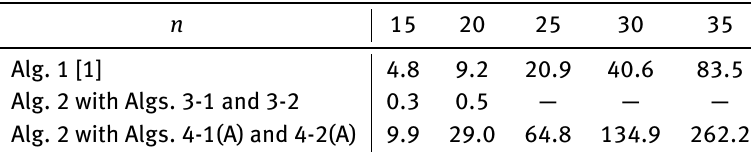
Table 5: Required times (sec) of Algorithms 1 and 2 for T with low symmetry. T were generated from a = (1, 1, 1) , b = (100, 100, 100) , and c = 1 in (17) – (19) , and the size of T is n 3 × n 3 . The symbol “—” means that the algorithm did not con- verge to the minimum singular values of T .